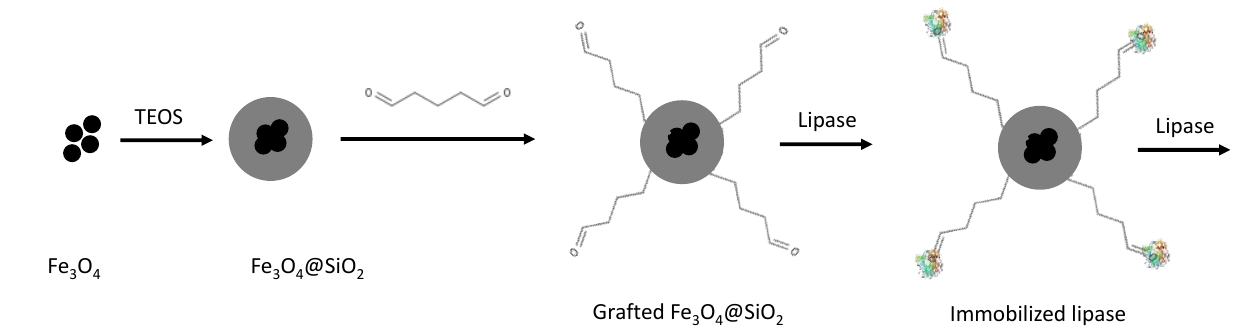
Figure 13. Schematic illustration of the synthesis of lipase immobilization on superparamagnetic mesoporous silica-SPION core–shell nanoparticles.